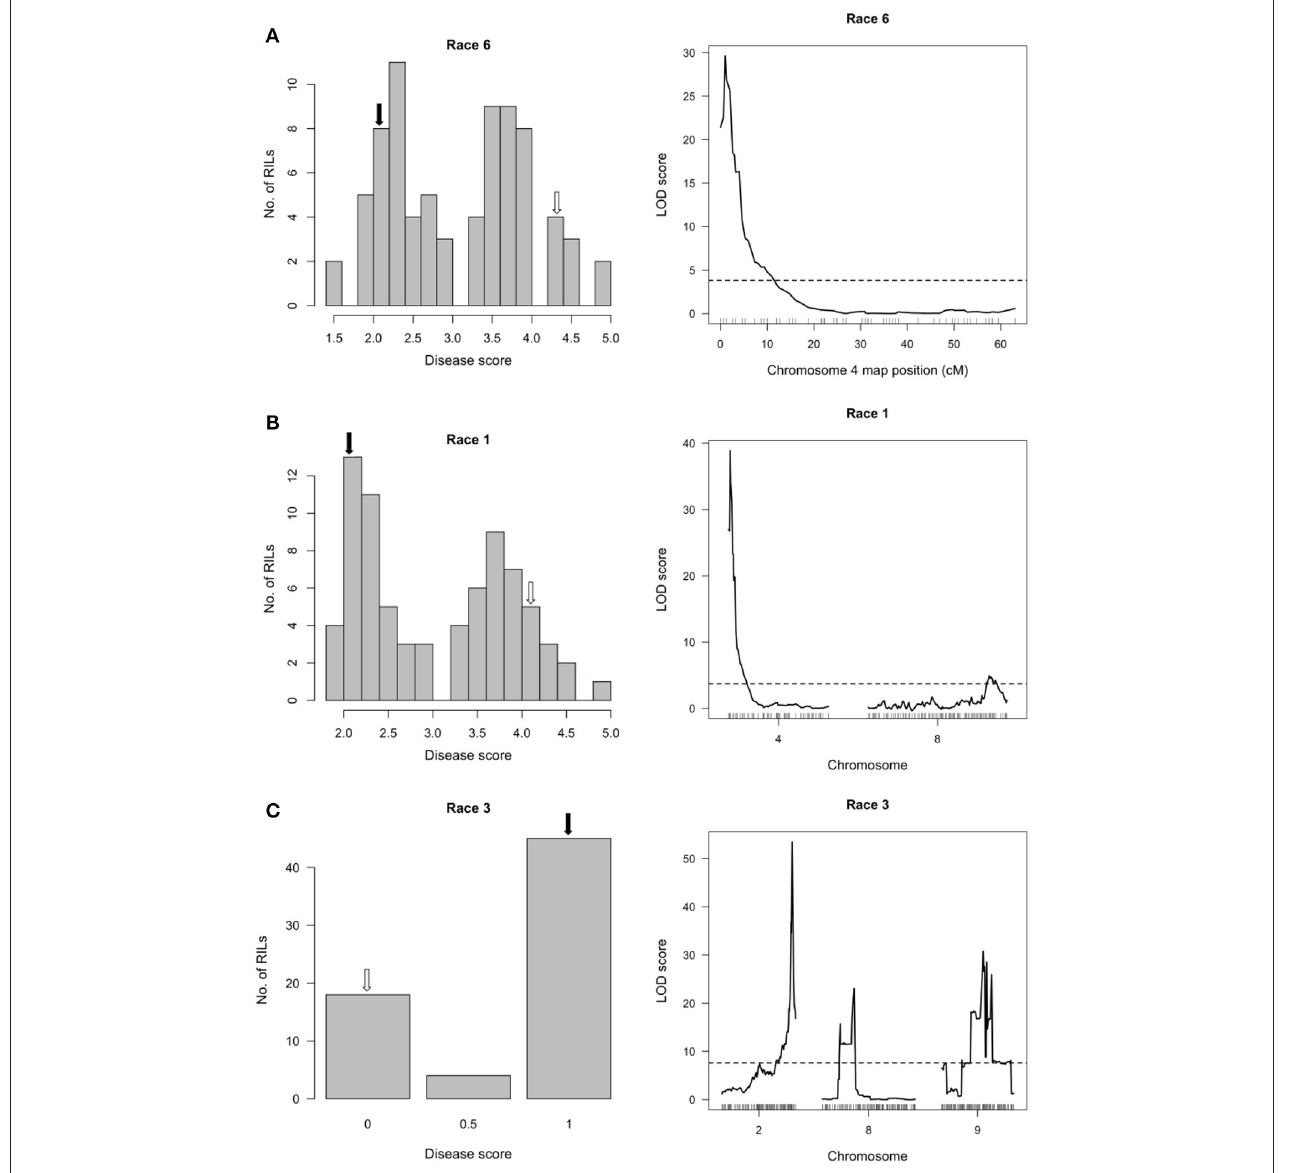
FIGURE 2 | Resistance mapping in the Phaseolus vulgaris SOA-BN × Edmund (SE) recombinant inbred population following separate inoculations with (A) Race 6, (B) Race 1 or (C) Race 3 of Pseudomonas syringae pv. phaseolicola detects major-effect QTL on Pv04 and Pv02. (Left graphs) Distribution of interaction phenotypes exhibited by SE inbreds in glasshouse experiments. For reaction to Race 6 or to Race 1, the phenotype scale ranges from highly resistant (score 1.0) to fully susceptible (score 5.0). For reaction to Race 3, a score of 0 corresponds to full susceptibility and a score of 1 corresponds to a severe hypersensitive reaction, indicating presence of Pse-3 . White arrows denote the mean disease score for SOA-BN and black arrows denote the mean disease score for Edmund. (Right graphs) LOD profiles obtained by one-dimensional and two-dimensional genome scans. QTL models were fitted and refined using the multiple imputation method. Dashed lines denote significance at the 0.05 probability